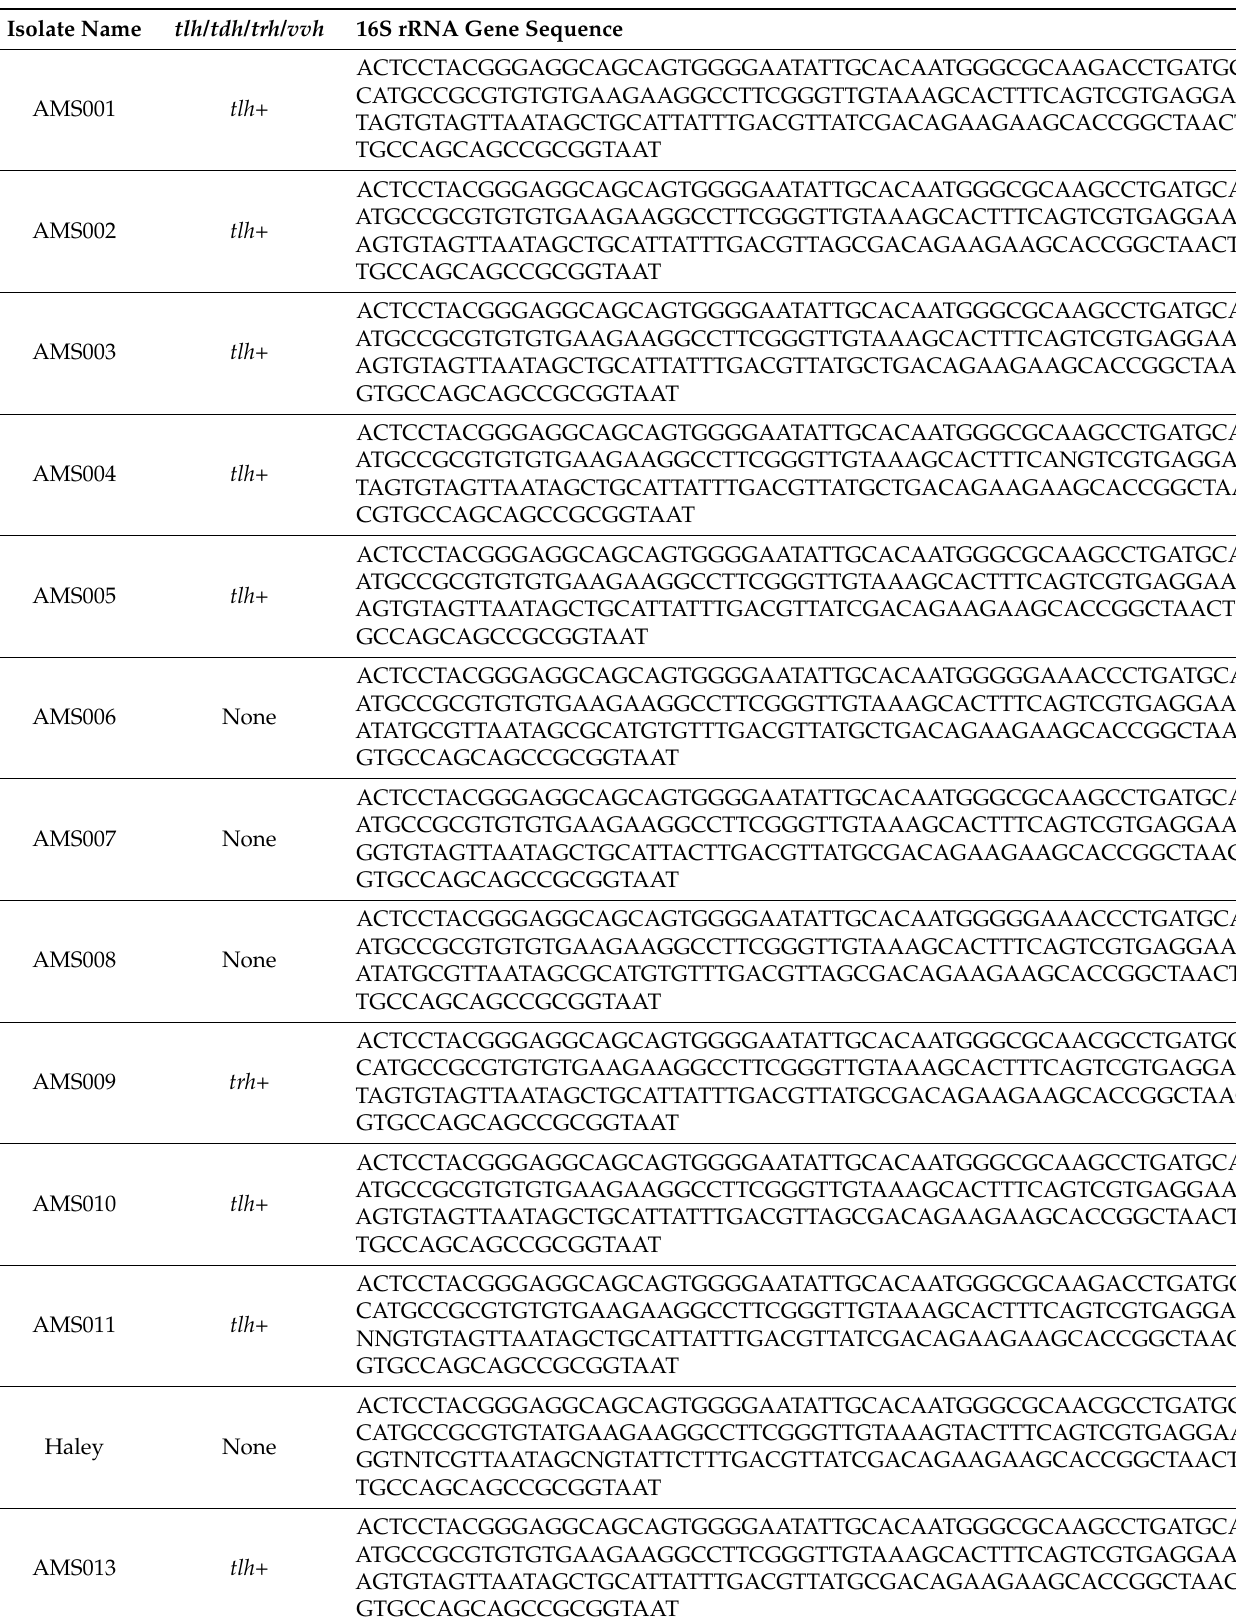
Table 1. 16S rRNA gene sequences and taxonomic identifications of isolates used in this